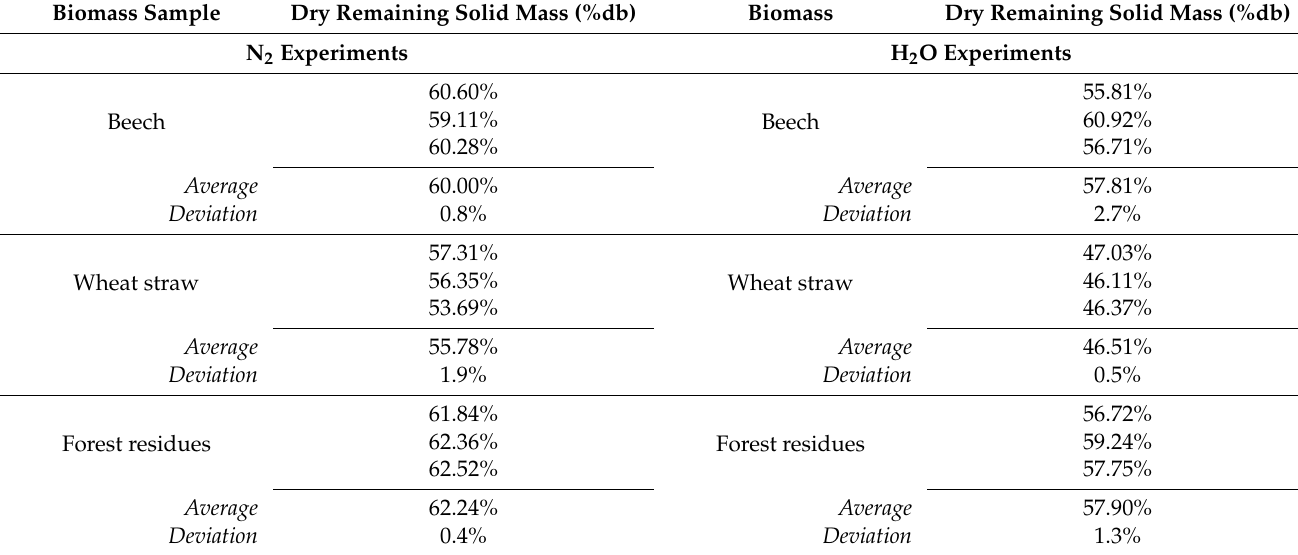
Table 3. Remaining solid mass in lab scale facility